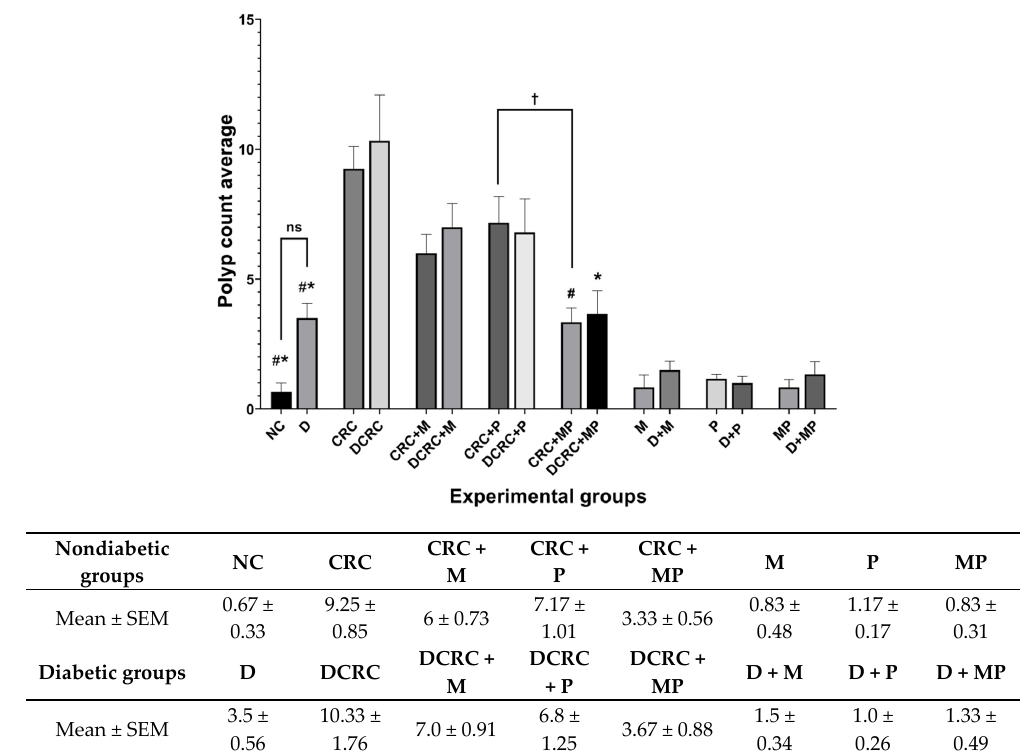
Figure 6. Polyp count variation in the different groups. Average polyp number was recorded on the day of sacrifice at week 13. Nondiabetic groups were compared to their experimental CRC control (CRC). Significance was expressed by # p < 0.05. On the other hand, diabetic groups were compared to their experimental diabetic CRC control (DCRC). Significance was expressed by * p < 0.05. Moreover, when comparing only two groups, connecting lines were used to indicate the compared groups with † p < 0.05, (ns) stands for nonsignificant, with n = 6 animals per